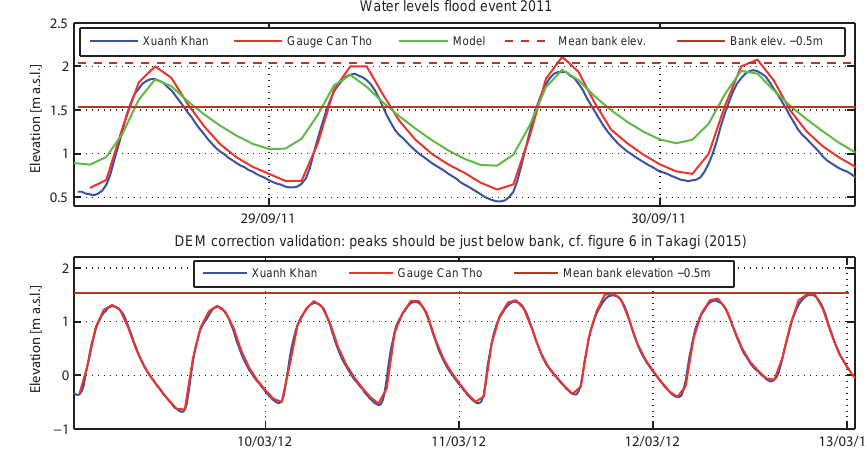
Figure 3. Correction of datum error of DEM. Top panel: comparison of bank elevation Ninh Kieu extracted from DEM and monitored and modelled water levels for the flood event 2011. Bottom panel: comparison of bank elevation extracted from corrected DEM with measured water levels and field campaign data published in Takagi et al. (2015).